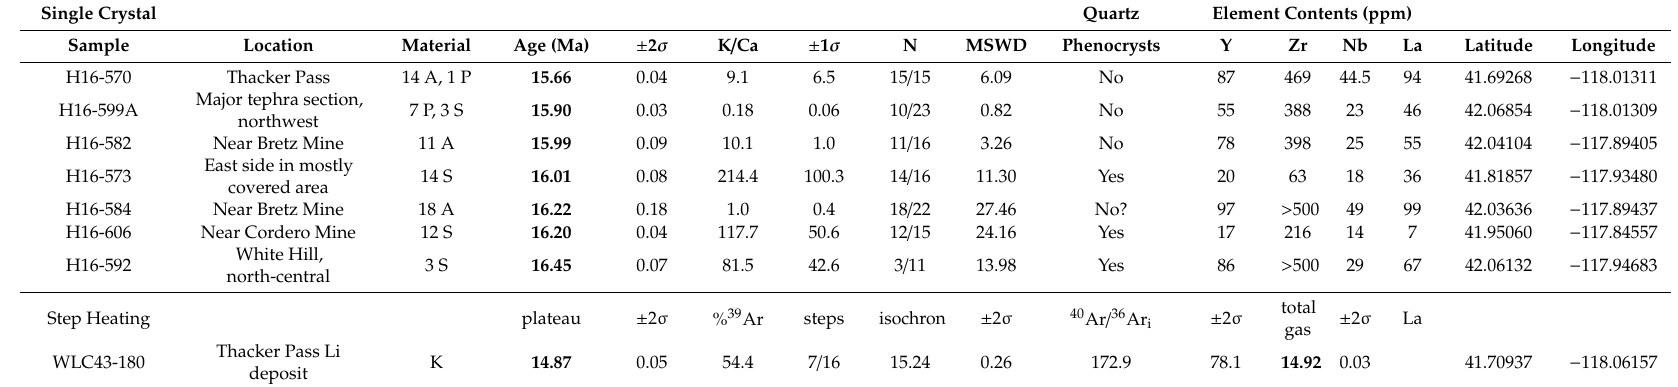
Table 2. 40 Ar / 39 Ar Ages of Tephra and Authigenic K-feldspar in Intra-Caldera Tu ff aceous Sediments of the McDermitt